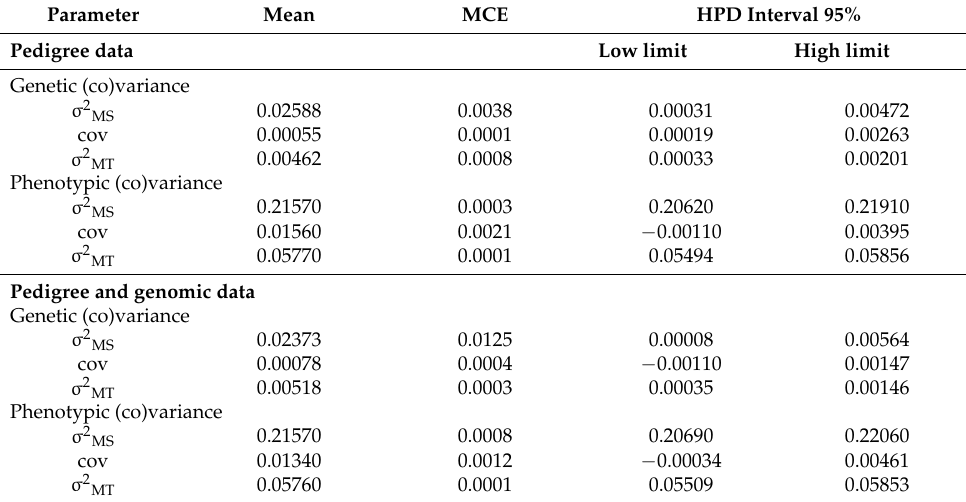
Table 7. Posterior means, Monte Carlo error (MCE) and highest posterior density (HPD) region of genetic and phenotypic parameter estimations of workability traits based on conventional data and conventional and genomic